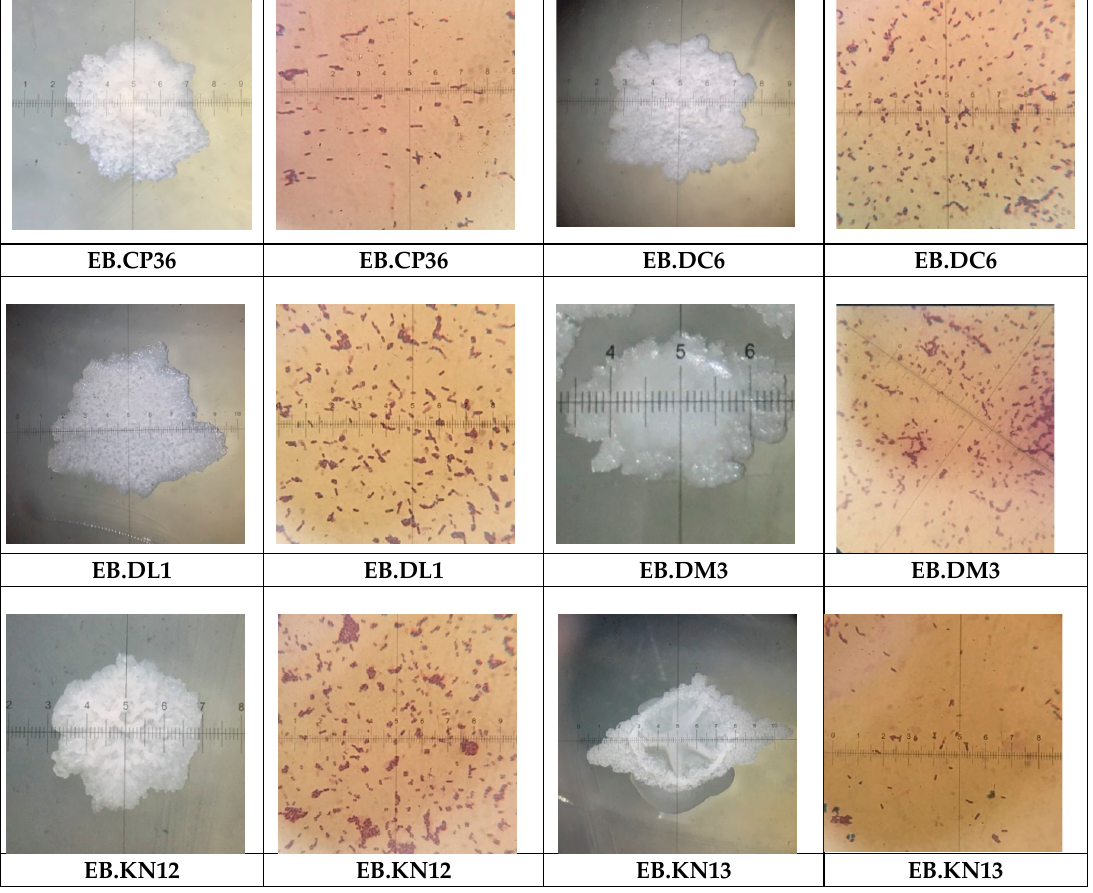
Figure 4. Colony and cell morphology of the six selected endophytic bacteria grown on TSA medium. Pictures were taken by stereo microscope (Model: Olympus SZ61, Japan), bar 1 mm. Gram-stained bacterial cells, taken by optical microscope (Model: Olympus, CH 30RF200, Japan), bar 100 mm. Characters in the boxes are names of the isolates. Table 2. Classification, identification, and GenBank code of the potent endophytic bacterial isolates.